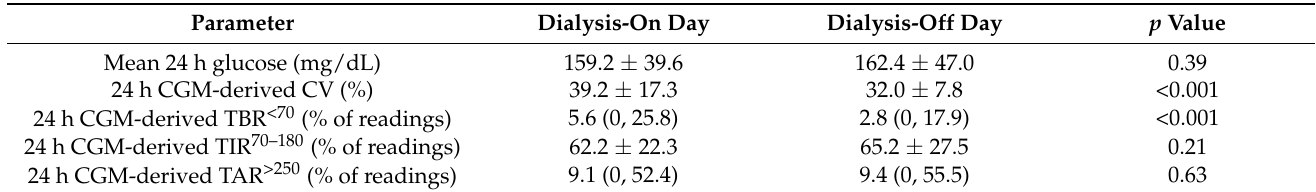
Table 3. Comparison of CGM-derived parameters between dialysis-on and dialysis-off days.